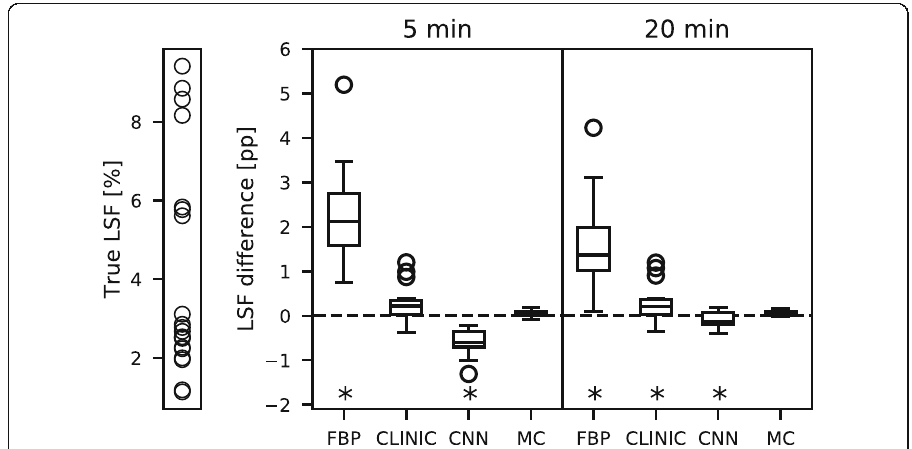
Fig. 5 The difference in percent point (pp) of the LSF for the 20 distributions in the validation set, for the four reconstructions methods and the two scan times. Additionally shown are the LSFs found in the ground truth distribution. The asterisk denotes the reconstruction methods that resulted in a significantly different LSF from the Monte Carlo-based reconstruction (Mann-Whitney U test at p <